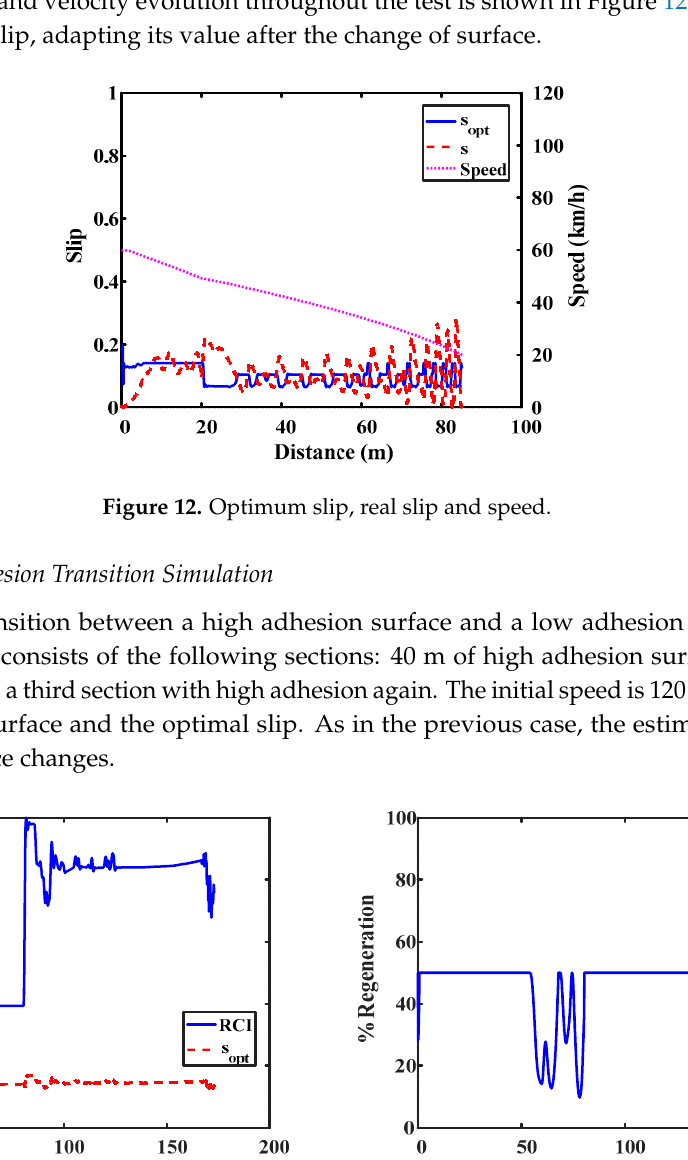
Figure 13. Estimation of road type and optimum slip ( a ) and regeneration rate ( b ).